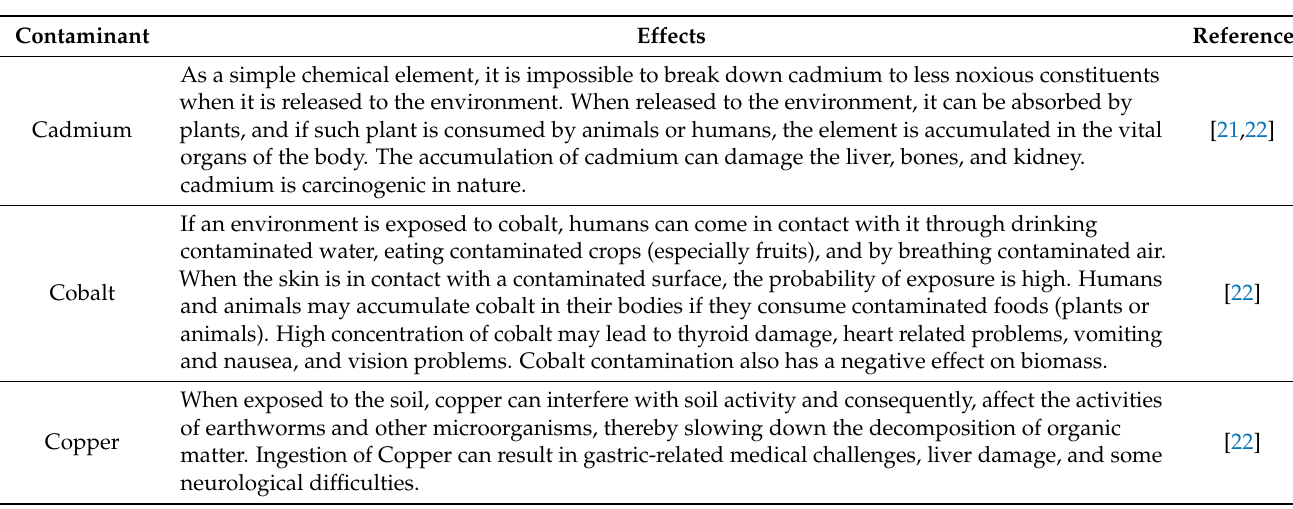
Table 1. The adverse environmental effects of the contaminants from